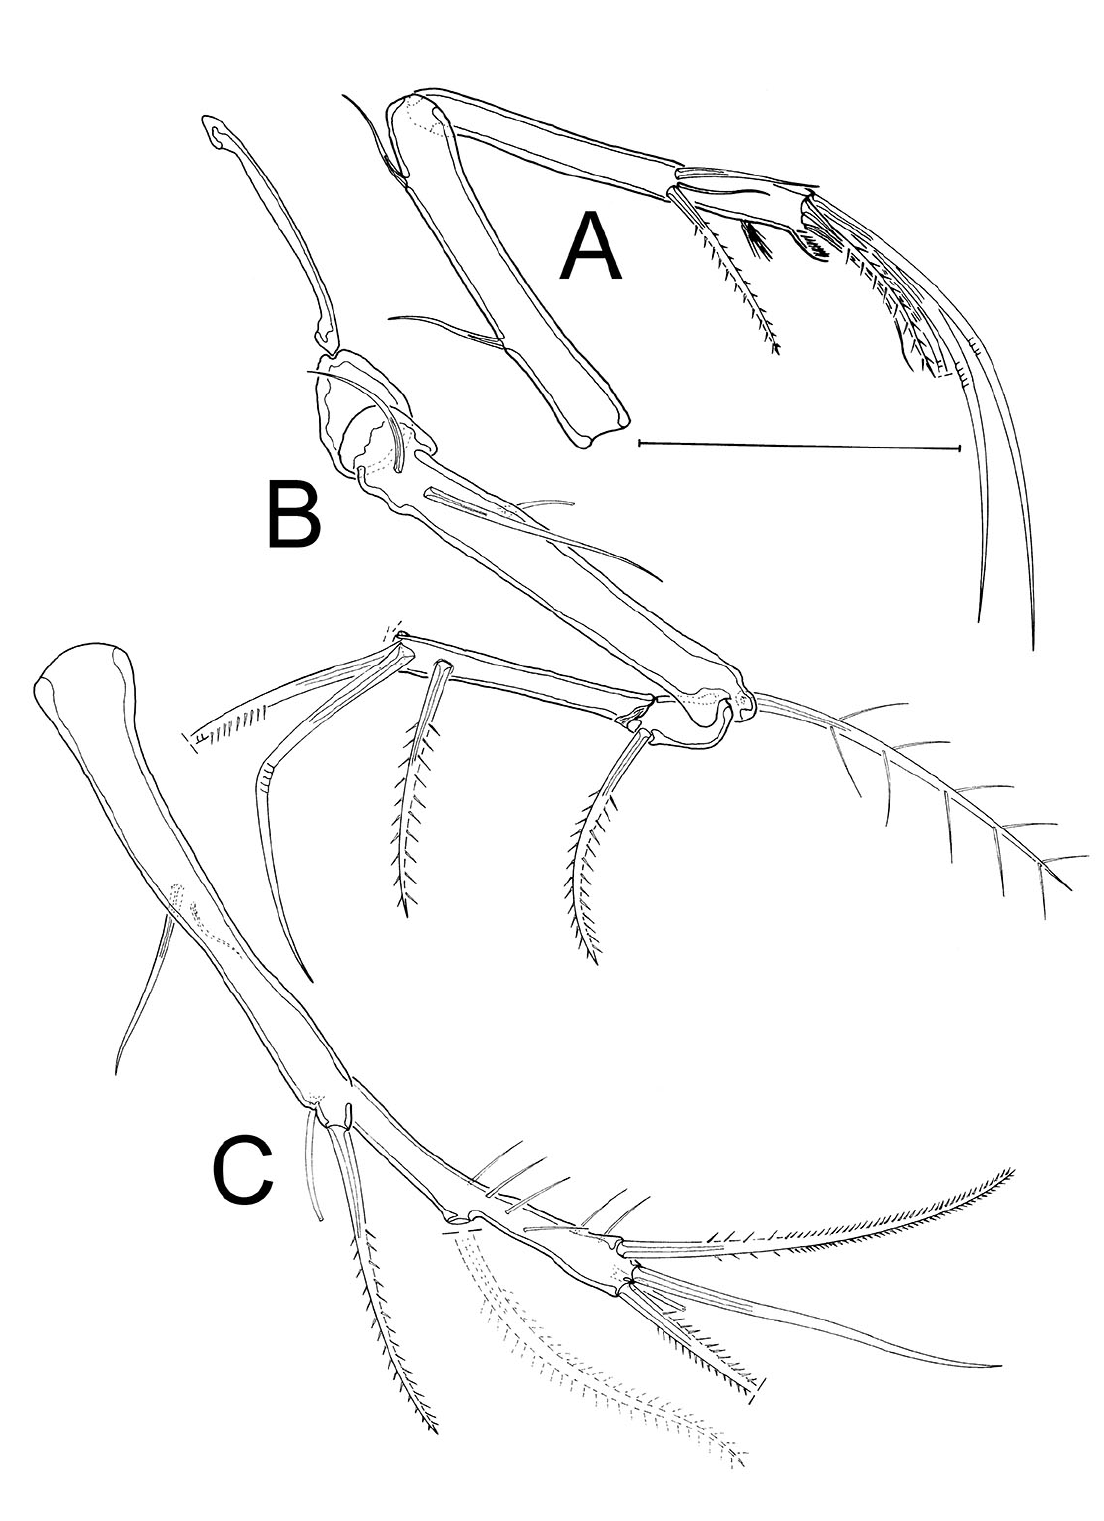
Fig. 5. Poropsyllus menzelae gen. et sp. nov. A . Male allotype (HUJ INVCRUCOP809), A2. B . Female holotype (HUJ INVCRUCOP808), P1. C . Female holotype (HUJ INVCRUCOP808), P5. Scale bar: 50